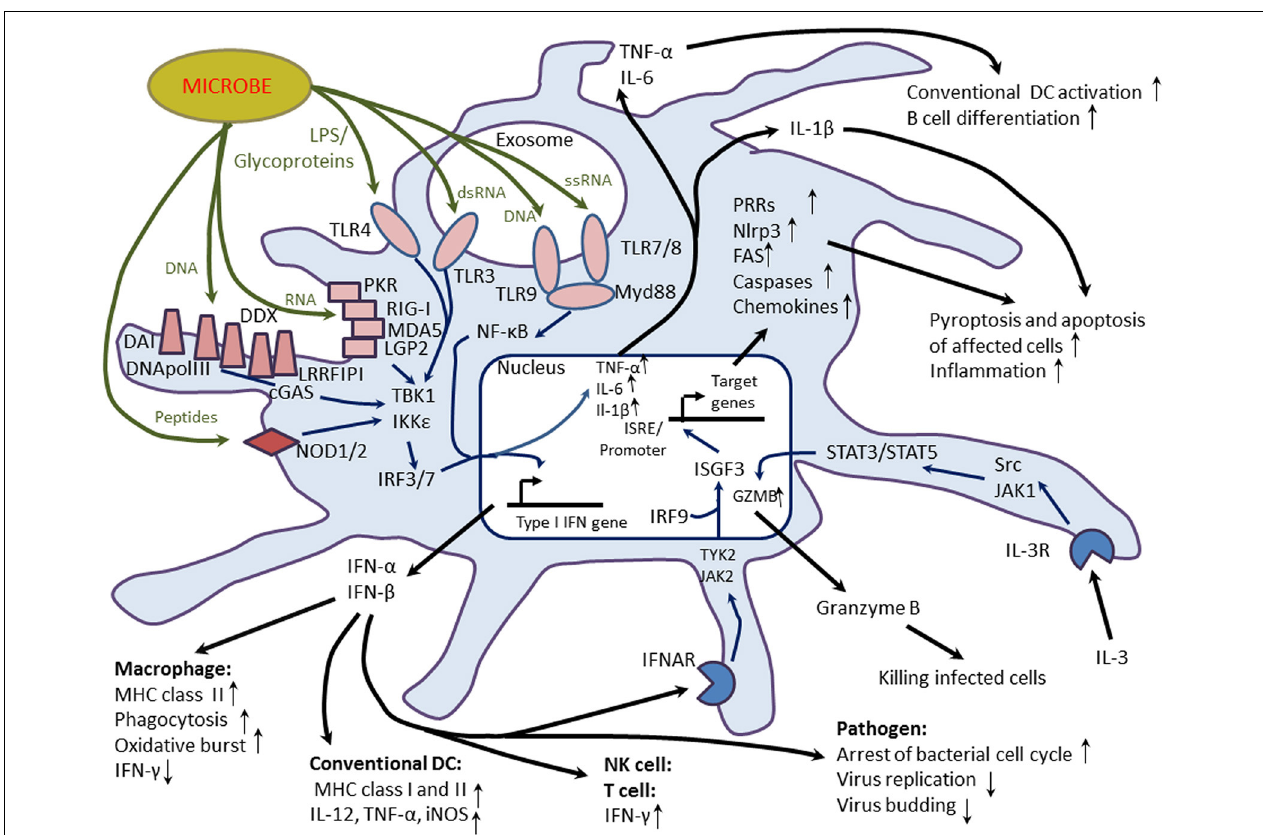
FIGURE 2 | Proinflammatory properties of plasmacytoid dendritic cells (pDCs). pDCs are capable to sense a variety of pathogen-associated molecular patterns (PAMPs) such as viral and bacterial peptides, peptidoglycans, lipopolysaccharides (LPS), RNA, and DNA through a range of pattern recognition receptors (PRRs) including Toll-like receptors (TLRs), double strand RNA-sensing receptor helicases (PRK, RIG-1, MDA5, and LGP2), and cytoplasmic receptors recognizing viral RNA and DNA (LRRFIPI, cGAS, DAI, DDX, and DNA polymerase III) or peptides (NOD1 and NOD2). TLR3, TLR7, TLR8, and TLR9 recognize pathogen-associated molecules in intracellular exosomes. PAMP-induced activation of PRRs leads to